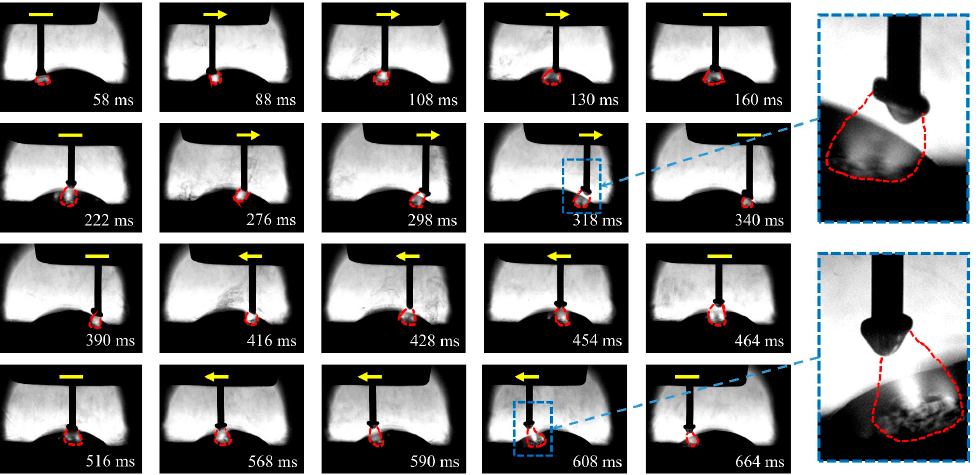
Figure 3. Arc shape variation during the swing deposition process.